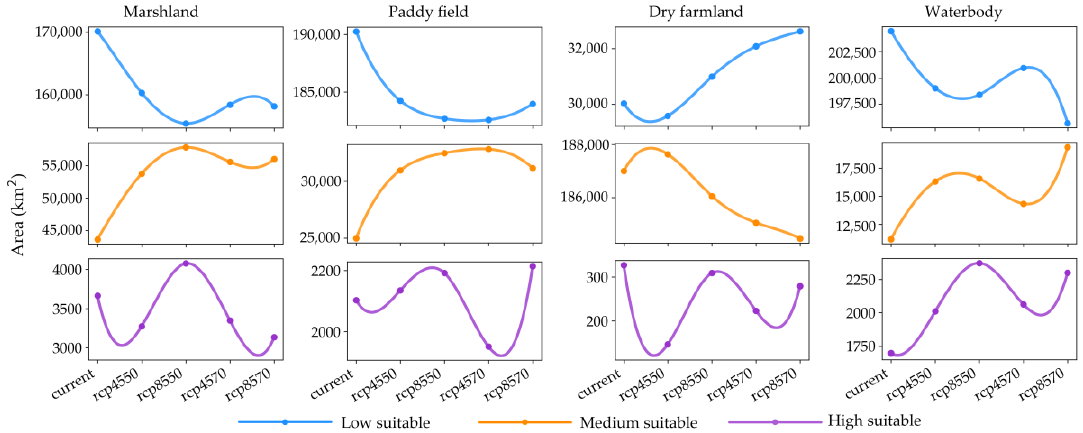
Figure 8. Area changes of suitability predicted for the wetlands and agriculture under climate change scenarios over the SNP.